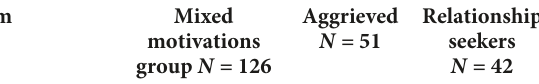
TABLE 6 Associations between consequences threatened and